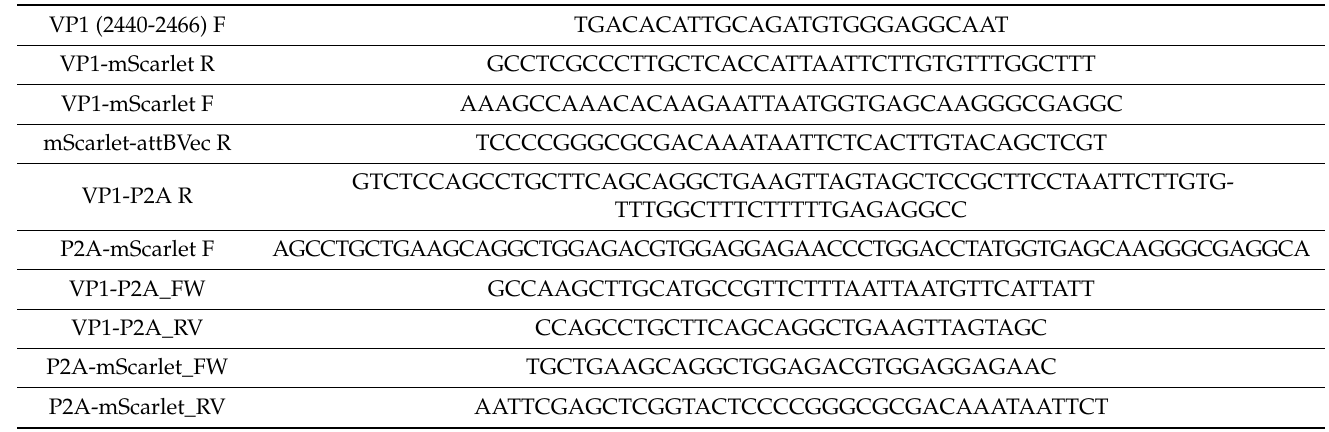
Table 2. List of primers used for overlapping PCR and Gibson